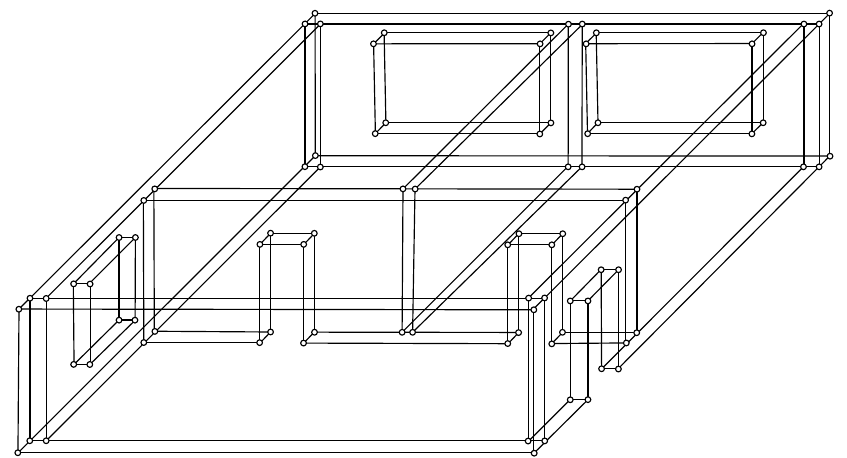
Figure 2. Linear complex for the building shown in Figure 1.